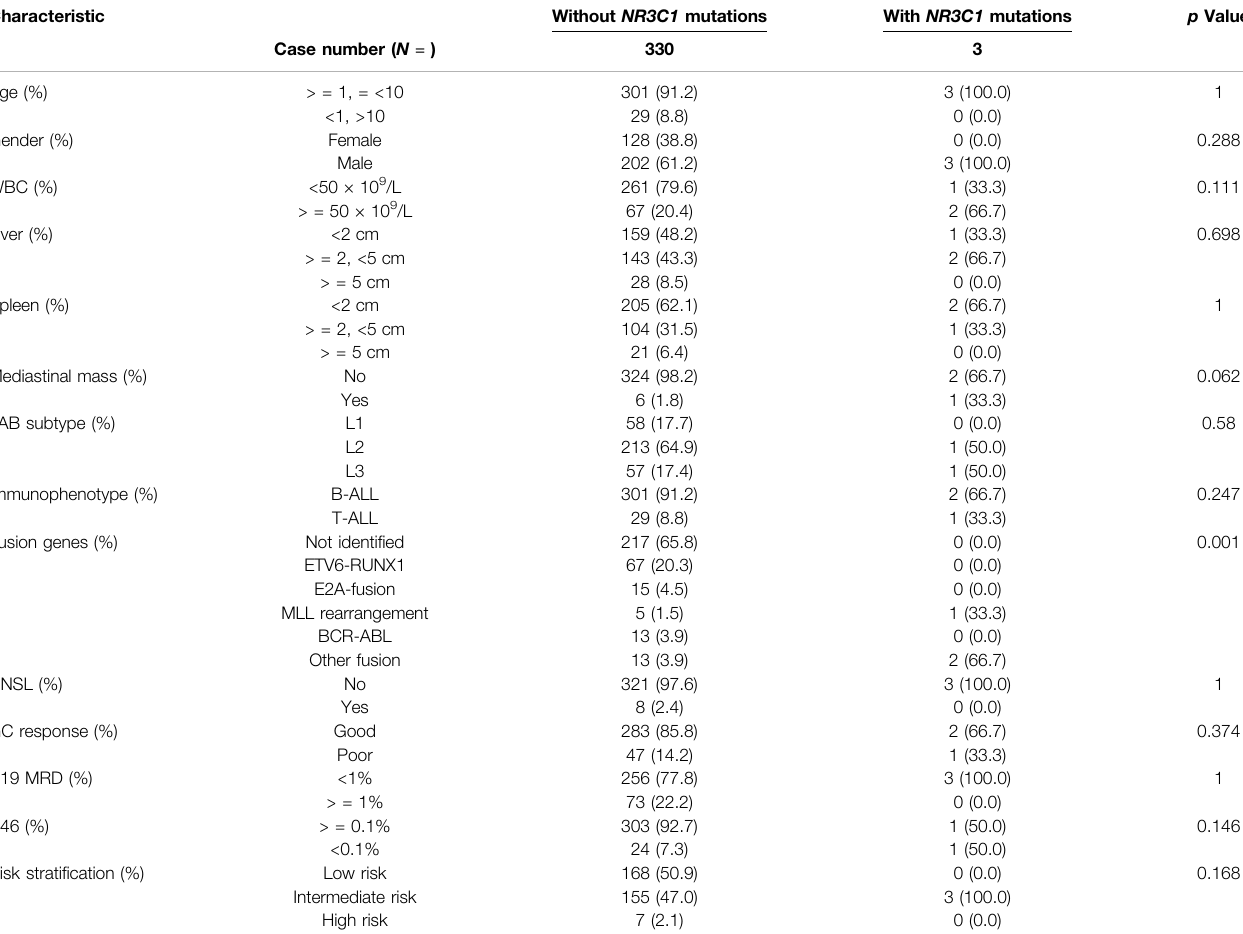
TABLE 1 | Baseline characteristics of newly diagnosed ALL patients with or without NR3C1 mutations. Characteristic Without NR3C1 mutations With NR3C1